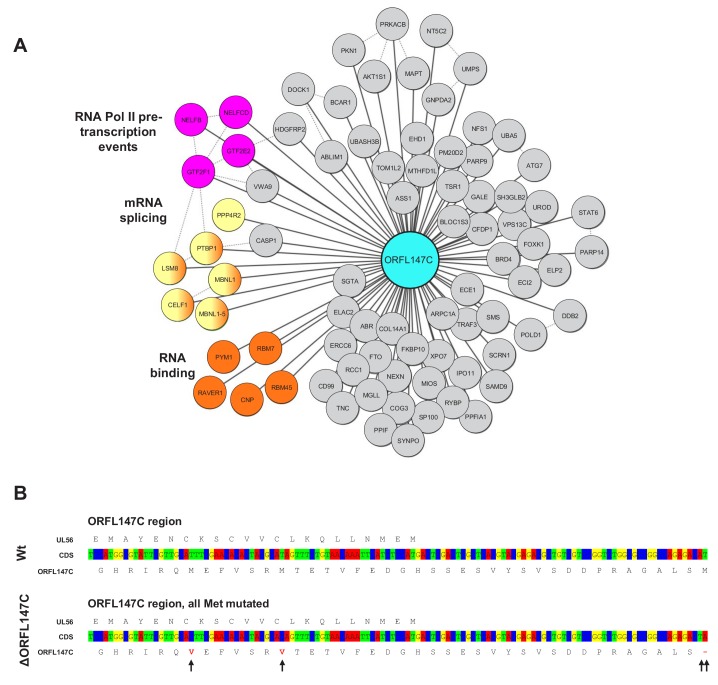
Further details of ORFL147C interactions, and construction of the ΔORFL147C virus.(A) Full interaction data for ORFL147C, annotated as described in Figure 4B. (B) Construction of a viral ORFL147C deletion mutant. The three most N-terminal methionines in ORF147C were mutated without affecting the amino acid sequences coded by UL56. The N-terminal protein sequences of ORFL147C and UL56 are shown, in addition to corresponding coding sequences in the region of the mutations.